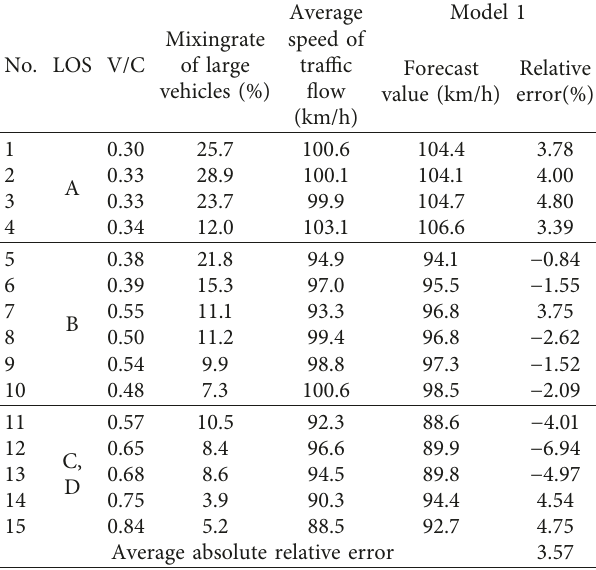
Table 6: Model prediction of the average speed of traffic flow in